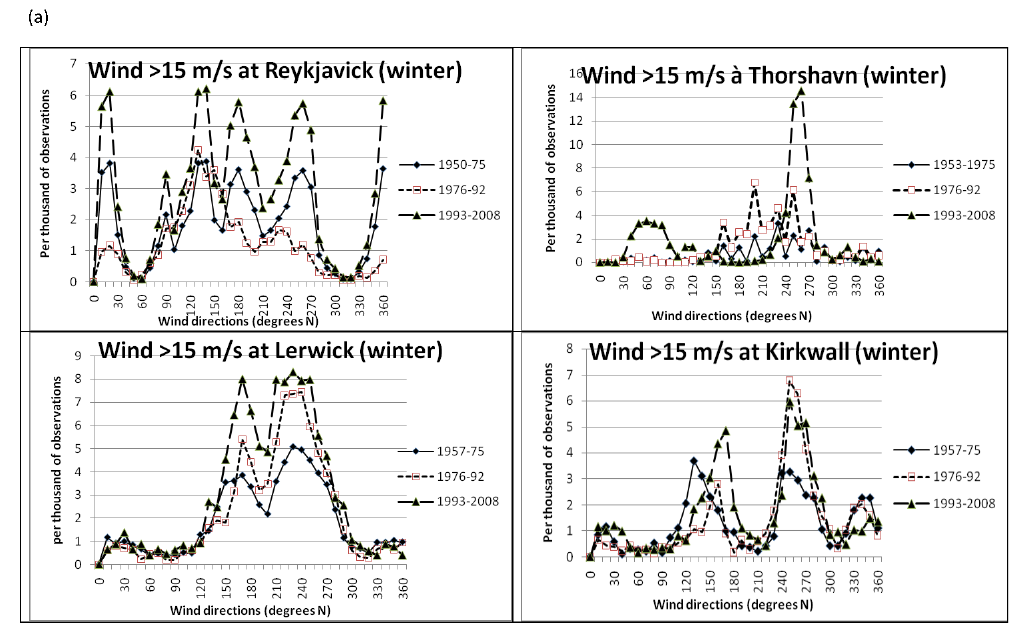
Fig. 6a. Distribution of wind directions for October to March measurements of wind speed > 15ms − 1 for the periods until 1975, 1976–1992 and 1993–2008: (a) Reykjavick, Thorshavn, Lerwick, Kirkwall; (b) Stornoway, Malin Head, Belmullet and Shannon; (c) Valentia, Brest, Belle-Ile and Cap